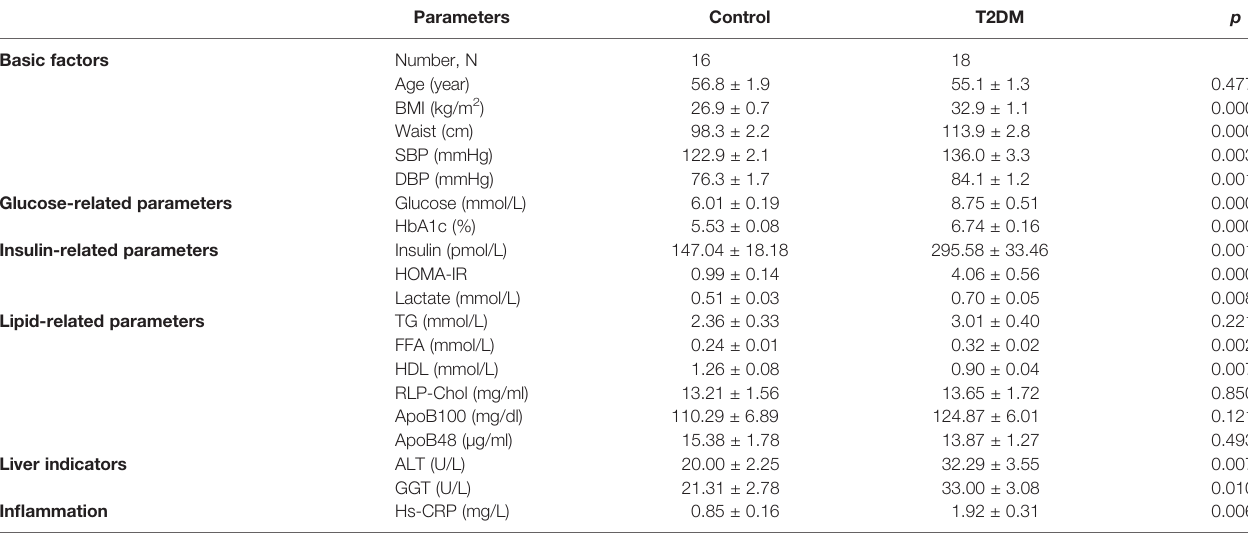
TABLE 1 | General characteristics of healthy controls and type 2 diabetic subjects. Basic factors